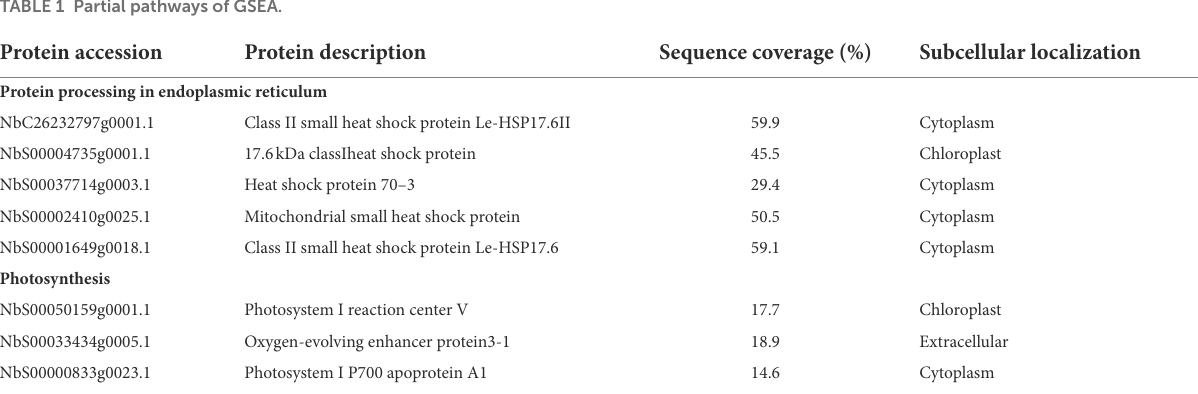
TABLE 1 Partial pathways of